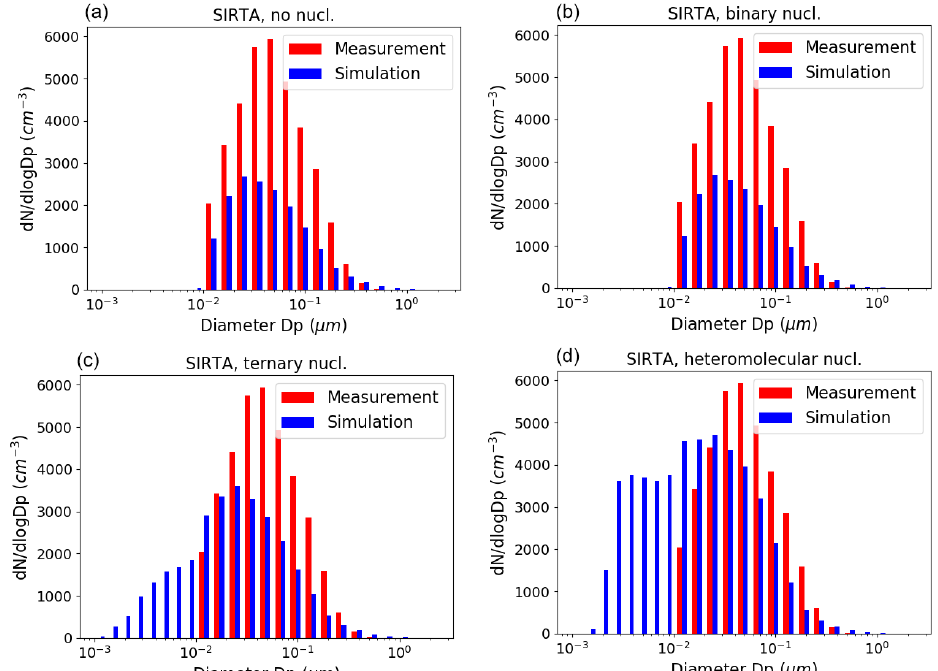
Figure 7. Size distribution of the number concentrations (in cm − 3 ) at the SIRTA site for the simulation without nucleation (a) , with binary nucleation (b) , with ternary nucleation (c) , and with heteromolecular nucleation (d) .